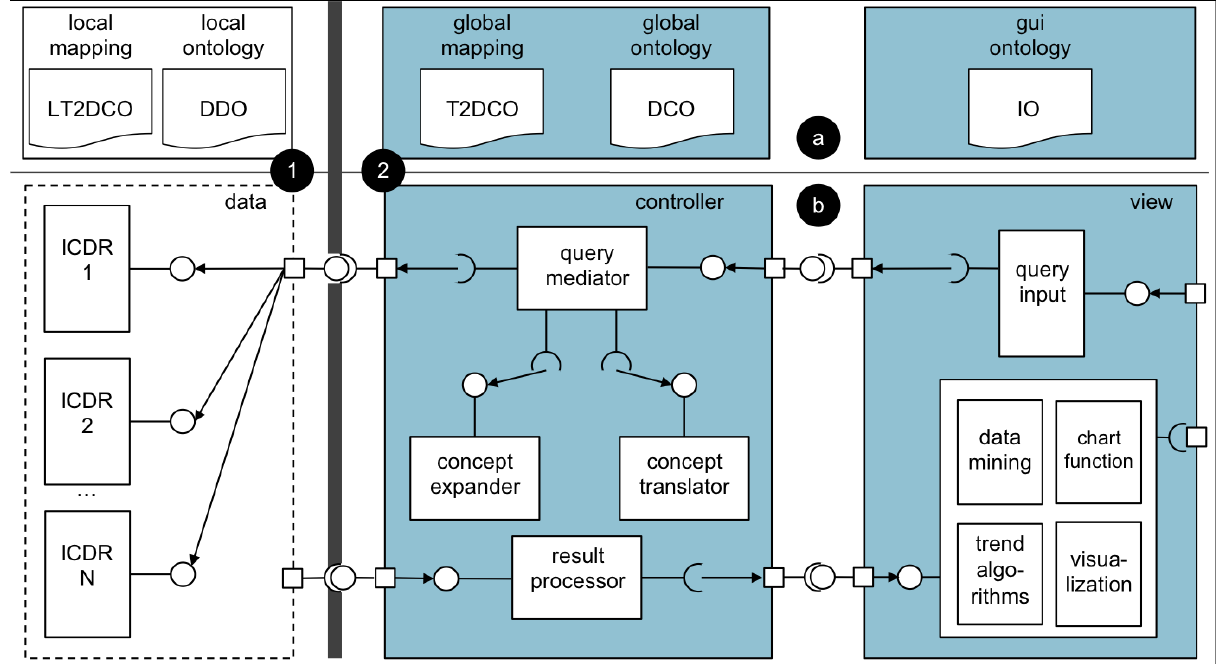
Figure 2. Antimicrobial Resistance Trend Monitoring System (ARTEMIS) architecture. (a) Ontology components. Models: data definition ontology (DDO), DebugIT Core Ontology (DCO), and interface ontology (IO). Mappings: local-terminology-to-DCO (LT2DCO) and global-terminology-to-DCO (T2DCO). (b) Run-time business components. (1) Data layer components are deployed within the demilitarized zone of the health care institution.